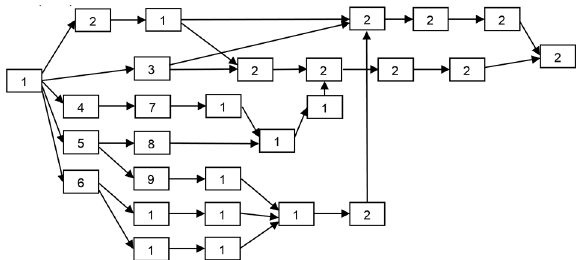
Fig. 1. Activity network of the exemplar project Table 2. Duration statistics of activities